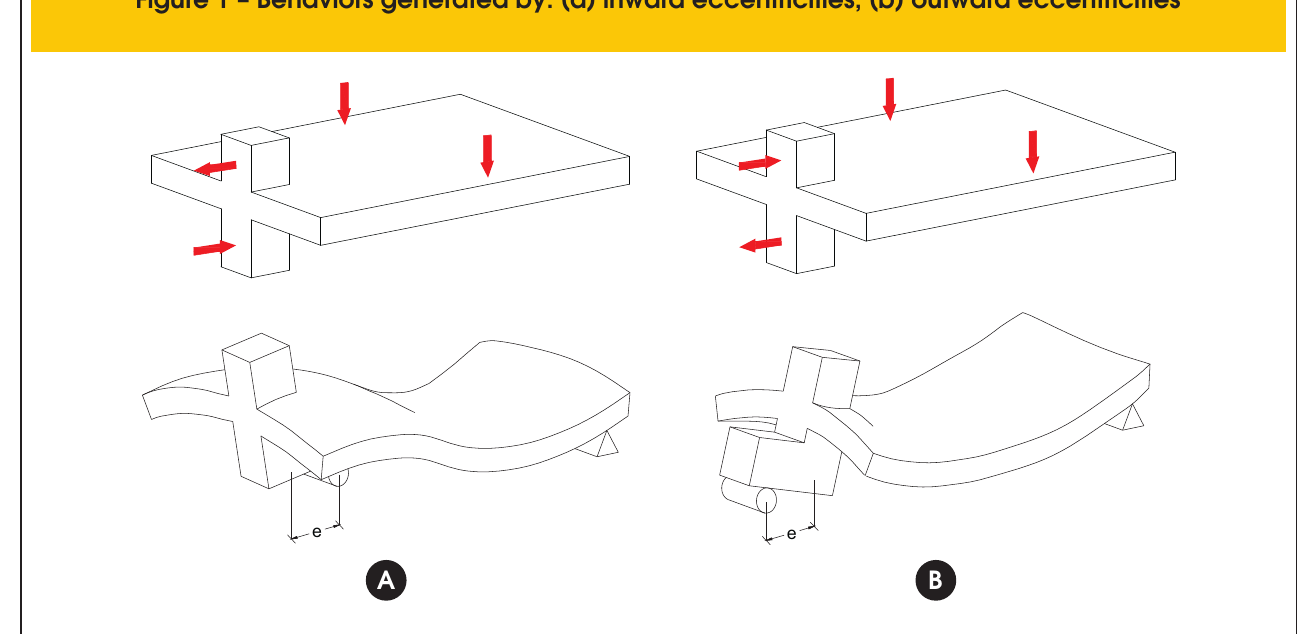
Figure 1 – Behaviors generated by: (a) inward eccentricities; (b) outward